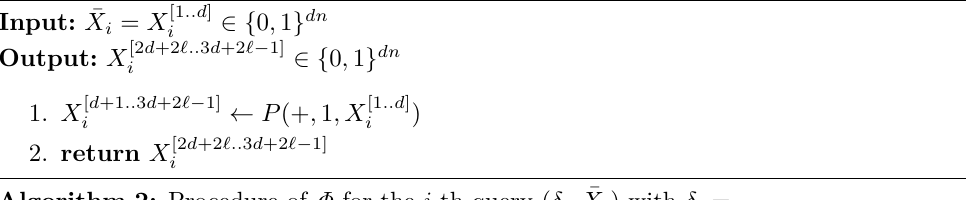
Algorithm 2: Procedure of Φ for the i -th query ( δ